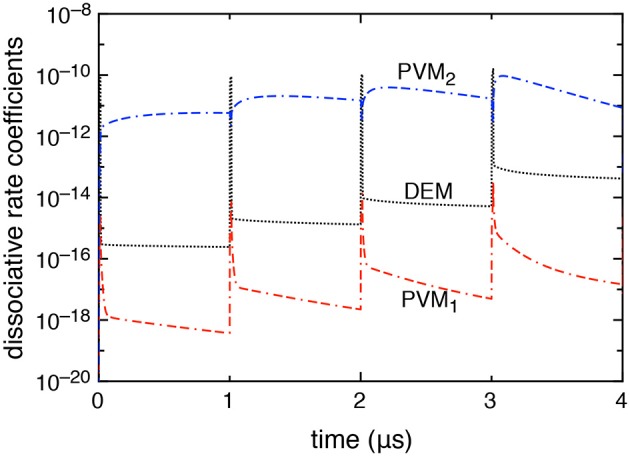
Dissociative rate coefficients by direct electron impact (DEM) and pure vibrational mechanism (PVM1, PVM2) as a function of time when DEA processes are included into the model (tid = 1 μs).